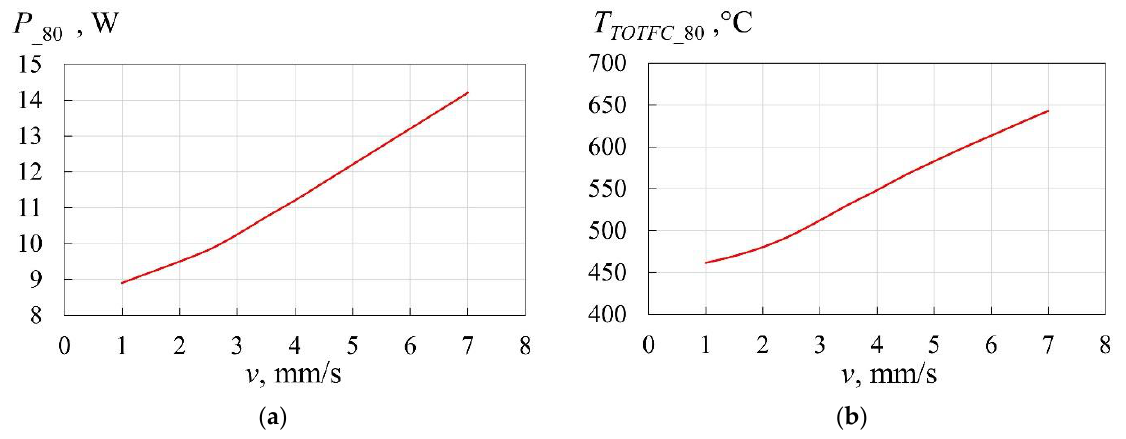
Figure 4. The dependences of the average laser radiation power P _80 ( a ) and the temperature of the TOTFC required for the vein wall temperature to reach 80 ◦ C T TOTFC _80 ( b ) on the traction speed ( ν ) of the TOTFC (the wavelength of laser radiation is 980 nm, the inner vein diameter is 5